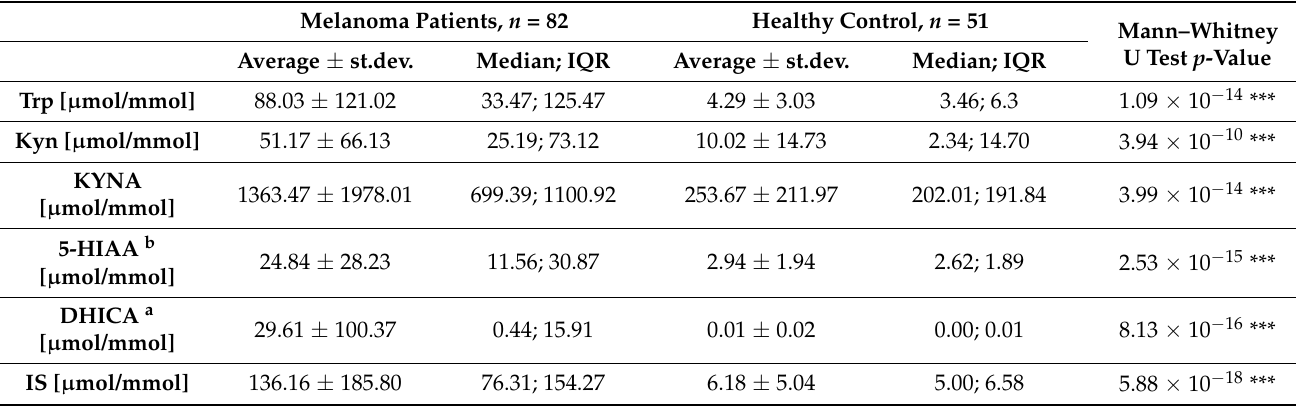
Table 2. Urinary Trp, Kyn, KYNA, 5-HIAA, DHICA, and IS levels. Melanoma Patients, n = 82 Healthy Control, n = 51 Mann–Whitney